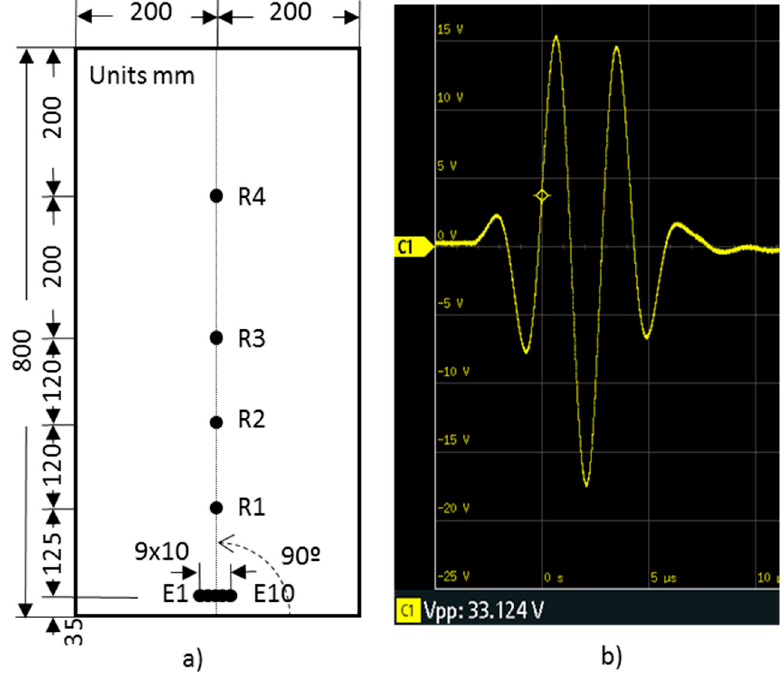
Figure 3. ( a ) Position of the PWAS for the basic UGWT and ( b ) excitation signal applied to the PWAS E5 for the basic UGWT.